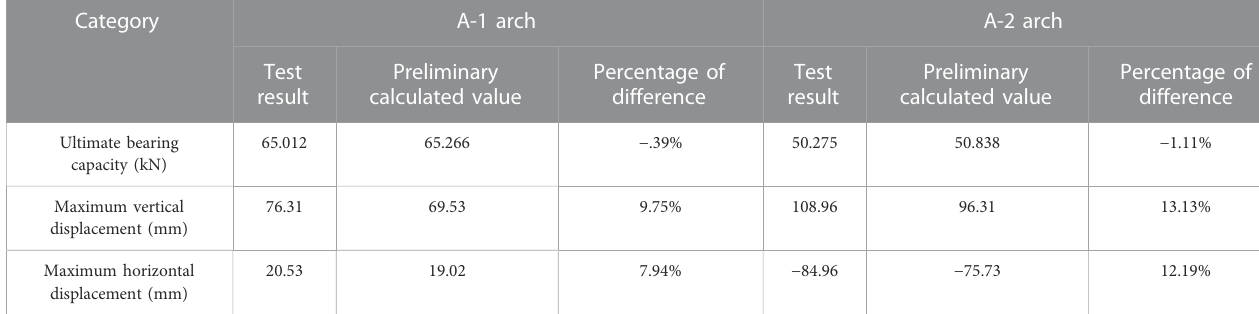
TABLE 5 Comparison between the test value and preliminary calculated value of the ultimate load.